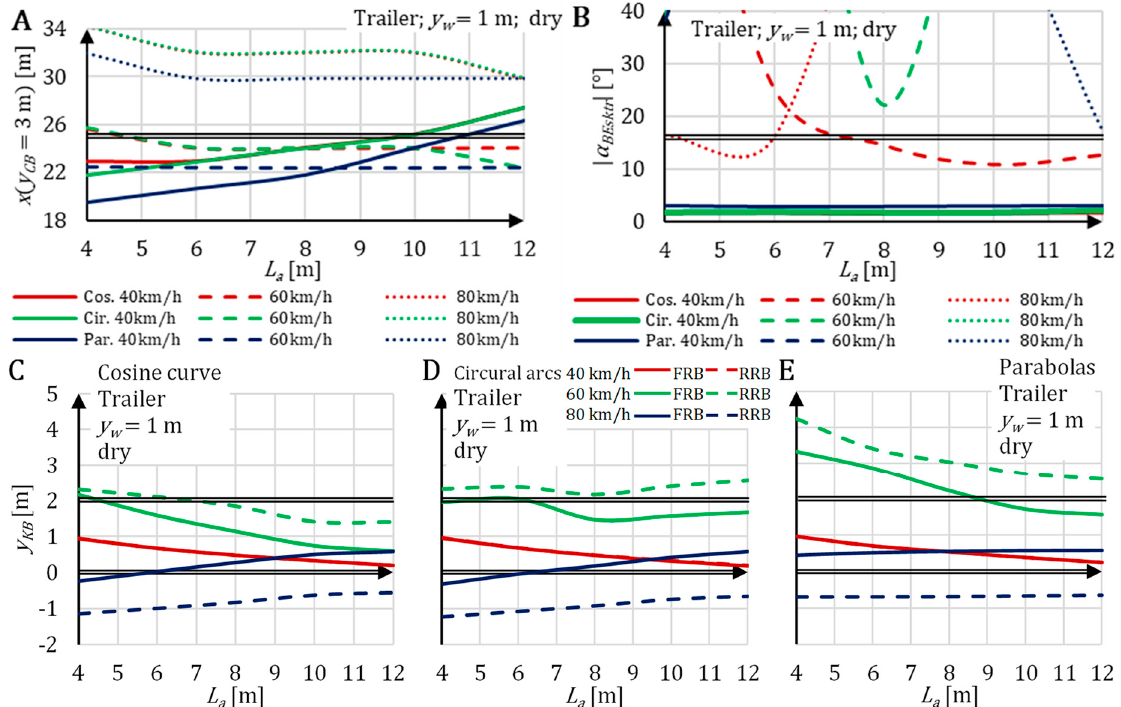
Figure 17. Summarized results of simulations of trailer’s motion in a CT unit during an obstacle avoidance maneuver for three trajectory planning methods (explanation in the text above). Vehicle speed values: 𝑣 = 40 km/h, 60 km/h, and 80 km/h; 𝐿 (cid:3028) values within a range of 4–12 m; road surface: dry.